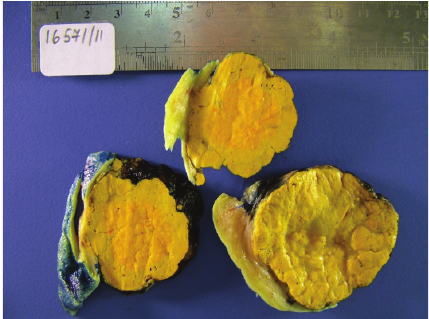
Figure 1: The tumoral mass has a yellow cut surface.